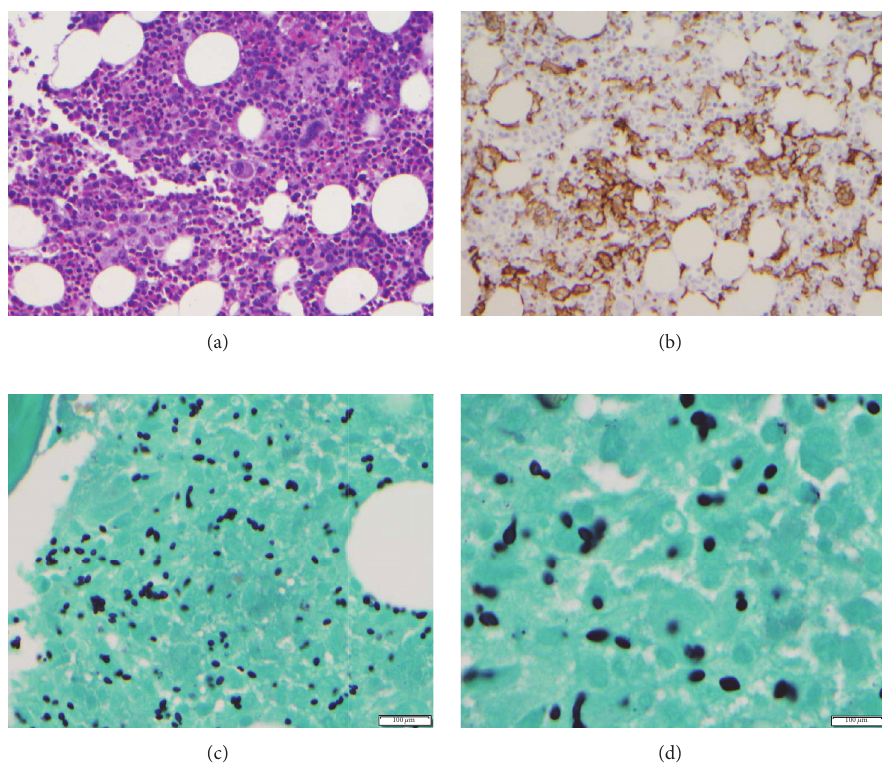
Figure 2: (a) Bone marrow biopsy with increased number of histiocytes, focally present in loose aggregates, hematoxylin and eosin stain, 40x. (b) CD163 staining on bone marrow biopsy highlighting histiocytes. (c)-(d) GMS (Gomori-Methenamine Silver) staining on bone marrow biopsy. Numerous budding fungal organisms with morphology consistent with Histoplasma are